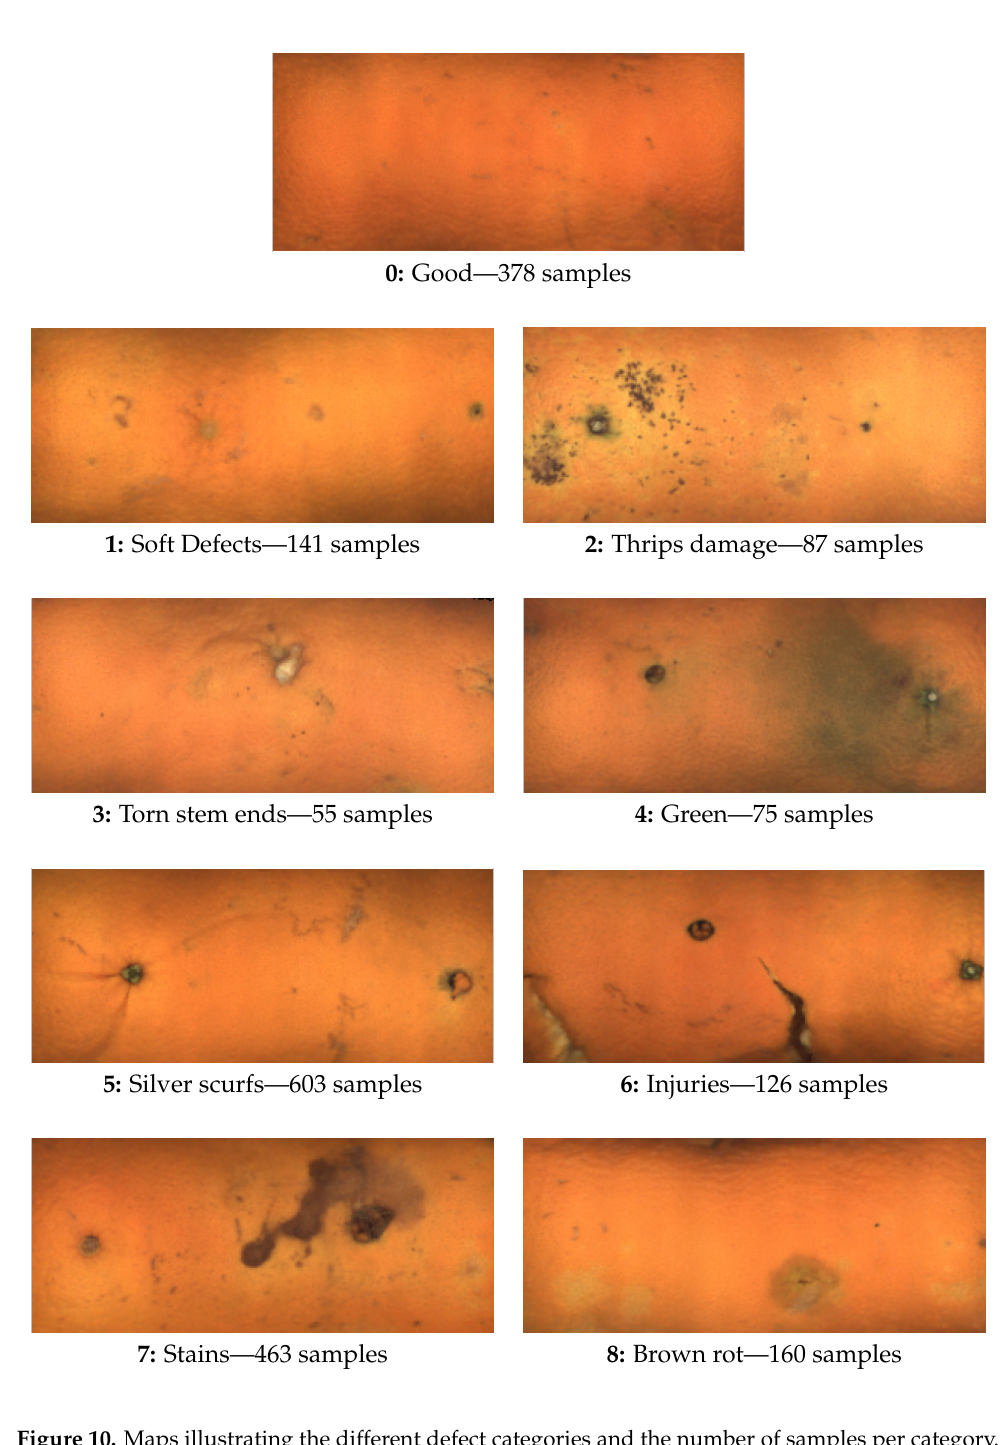
Figure 10. Maps illustrating the different defect categories and the number of samples per